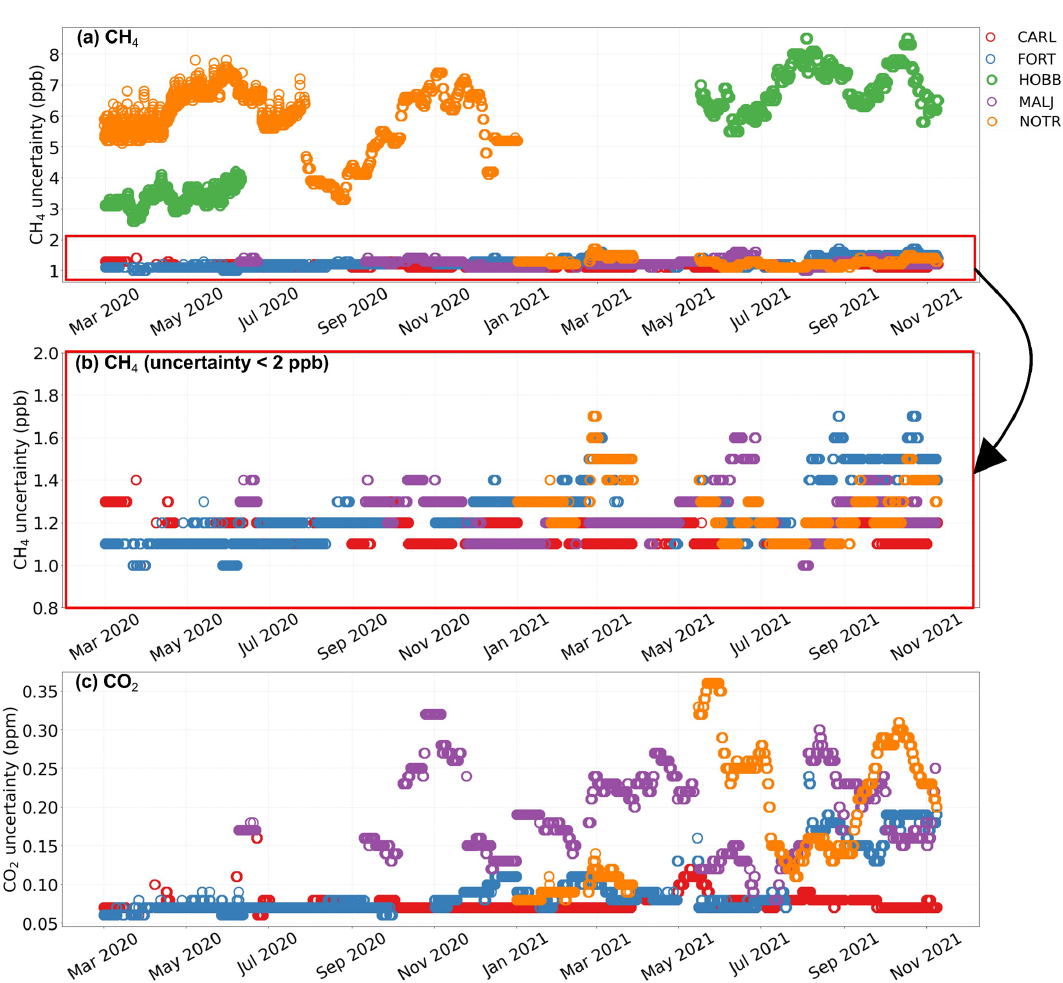
Figure 3. CH 4 and CO 2 uncertainties from March 2020–November 2021, at the five sites: Carlsbad (CARL), Fort Stockton (FORT), Hobbs (HOBB), Maljamar (MALJ), and Notrees (NOTR). (a) CH 4 uncertainty. (b) CH 4 uncertainty close-up ( < 2ppb). (c) CO 2